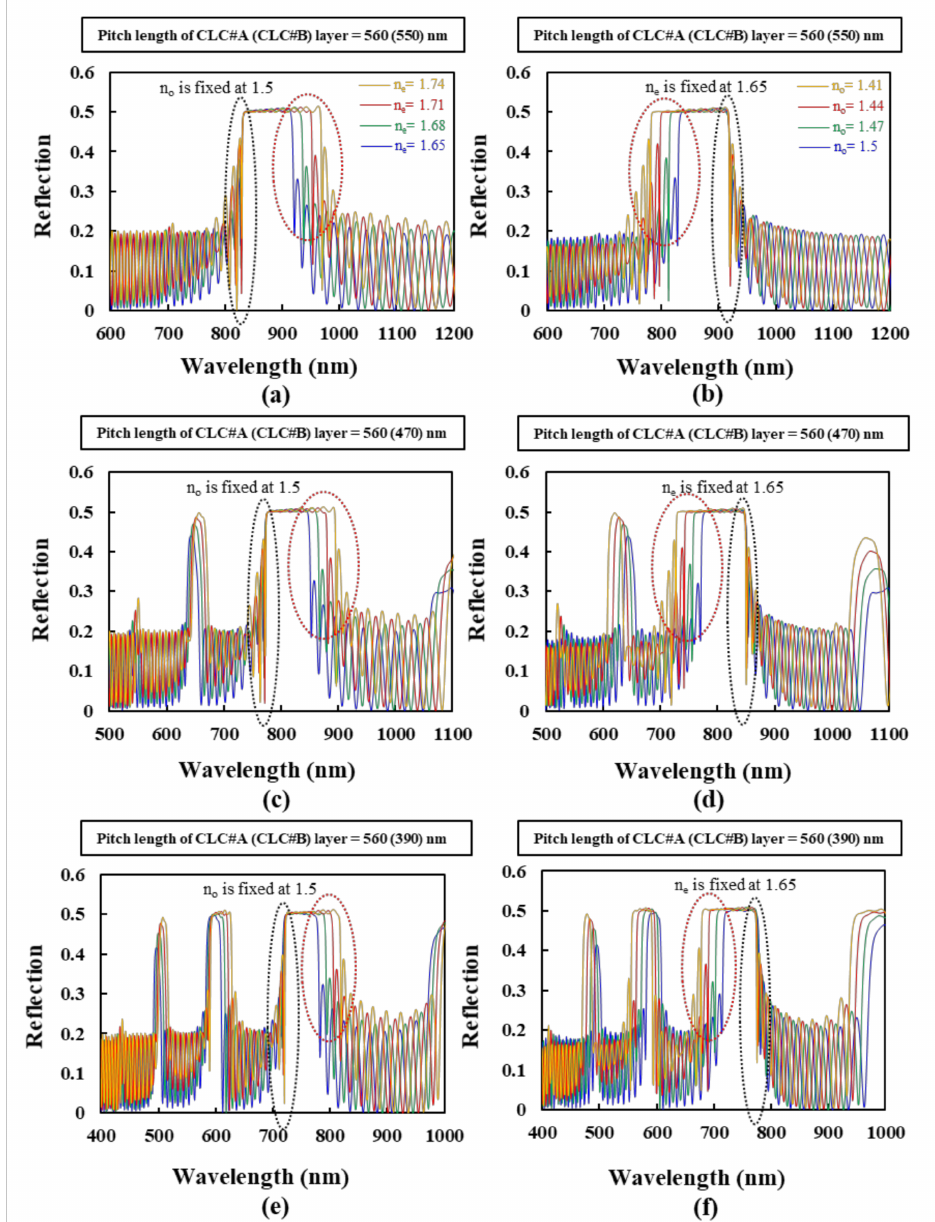
Figure 3. The simulation results of the reflection spectra of BLCPFs when the pitch length of CLC#A is fixed at 560 nm, and the pitch lengths of CLC#B are ( a , b ) 550 nm, ( c , d ) 470 nm, and ( e , f ) 390 nm. The various n e [n o ] values of CLC#A and CLC#B of the blue, green, red, and yellow reflection spectra presented in ( a , c , e ) [( b , d , f) ] are 1.65, 1.68, 1.71, and 1.74 [1.5, 1.47, 1.44, and 1.41], respectively; the fixed n o (n e ) of the LCs in ( a , c , e ) [( b , d , f )] is 1.5